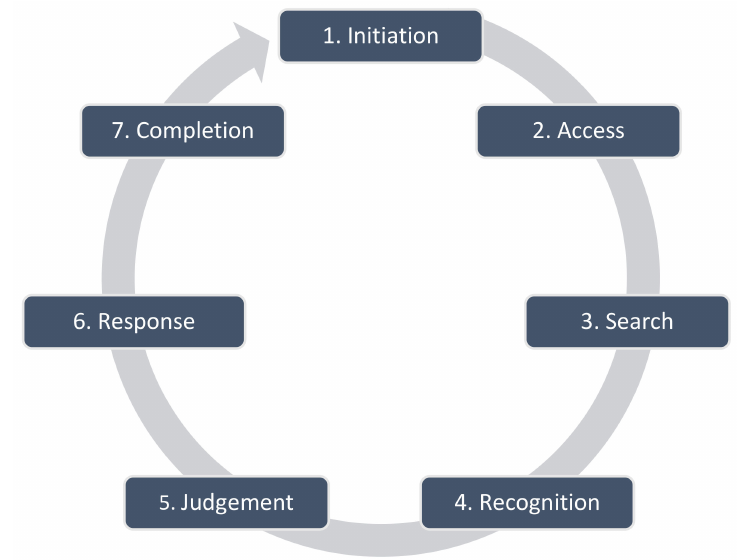
Figure 26. Visual Inspection